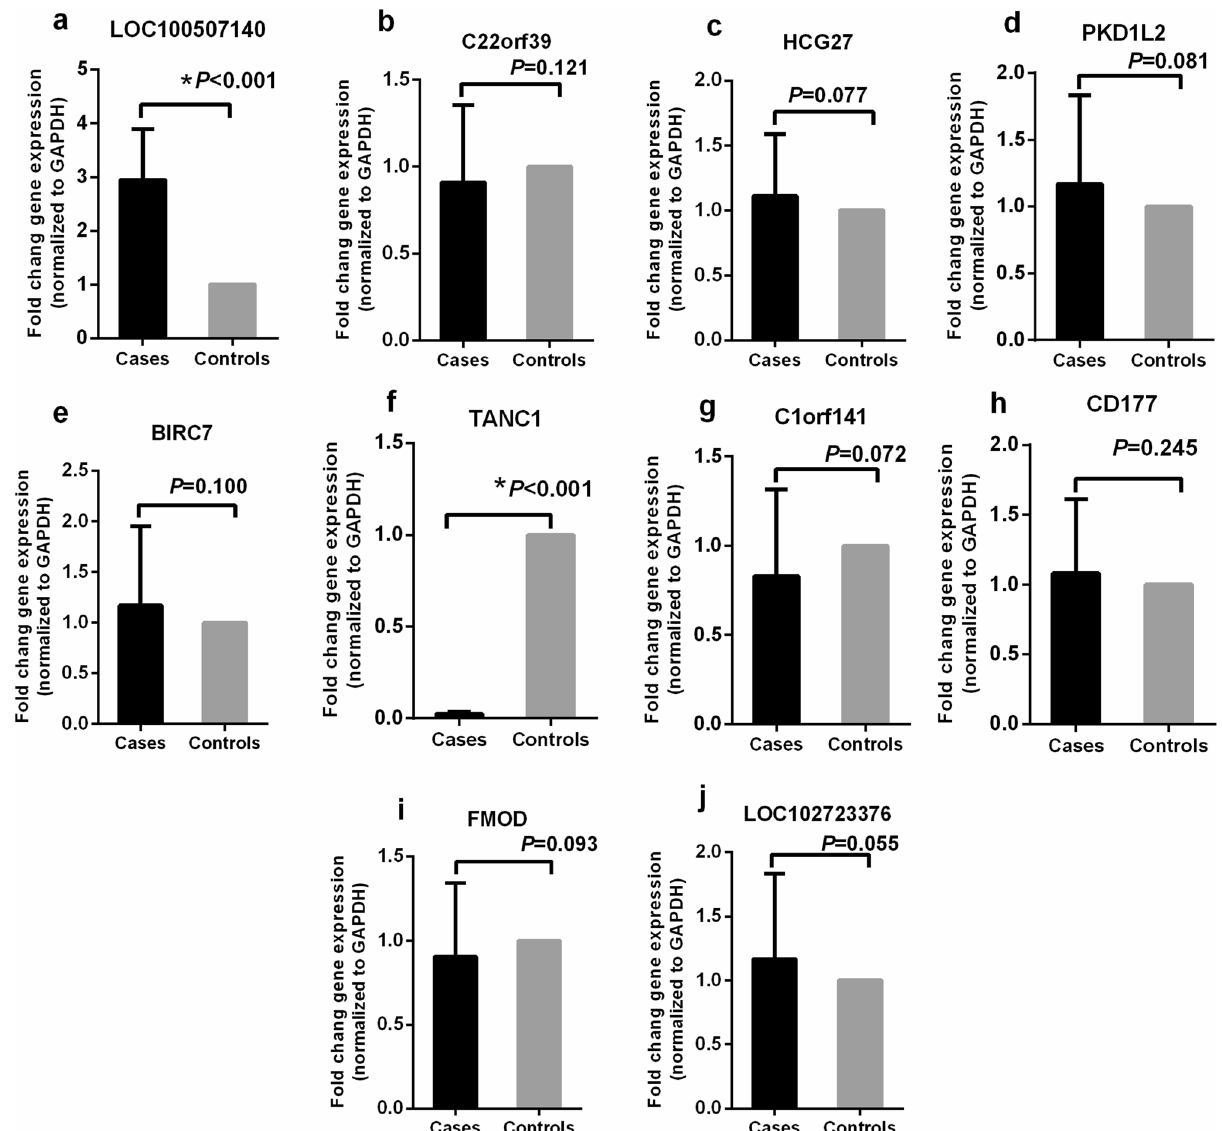
Figure 4. Expression of selected genes in the blood samples of cases and controls. Relative mRNA quantification of 10 candidate genes using RT-qPCR in cases (N = 60) compared to controls (N = 60) blood samples. Data are represented as mean ± SD. * P <